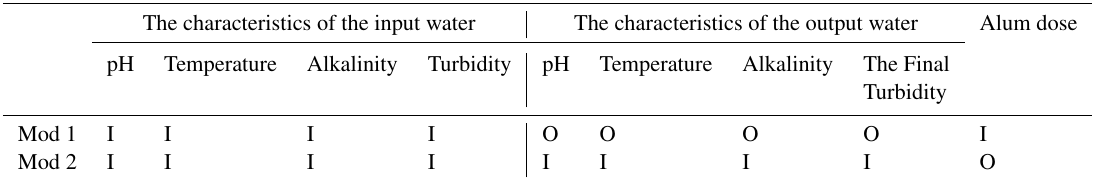
Figure 1. Scatter plots of actual versus predicted values for the validation data obtained using model 1 (a) Actual pH, (b) Actual Alkalinity, (c) Actual Turbidity, and (d) Actual Temperature. Table 2. Models inputs and